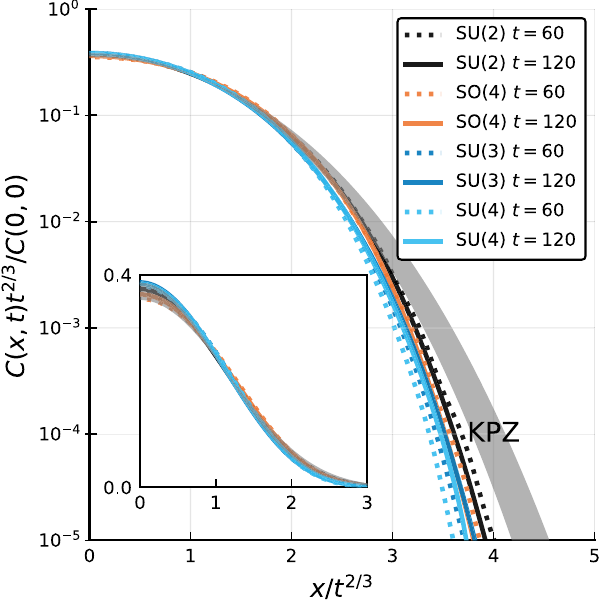
FIG. 1. Dynamical charge correlation functions computed with TEBD, showing asymptotic scaling with dynamical exponent z ¼ 3 = 2 for each of the integrable chains, measured by (top) the width Δ x ð t Þ of the expanding charge profiles and (bottom) the return probability C ð 0 ; t Þ . The dashed lines in the background show Δ x ∝ t 2 = 3 and C ð 0 ; t Þ ∝ t − 2 = 3 .